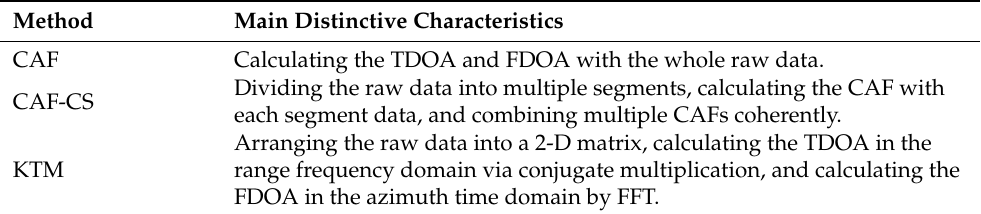
Table 1. Comparison of three